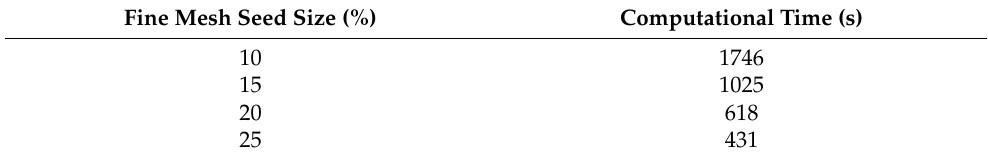
Table 6. Computational times.